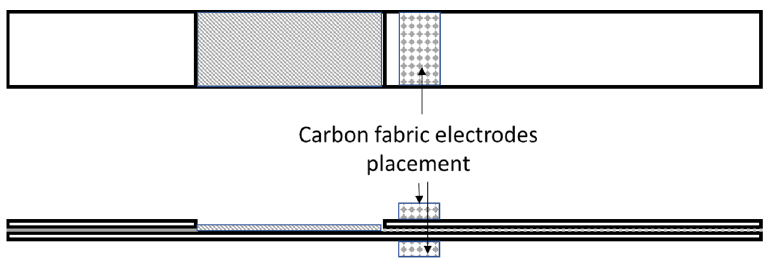
Figure 3. Schematic illustration of the attached carbon fabric electrodes setup on lap strap geometry.